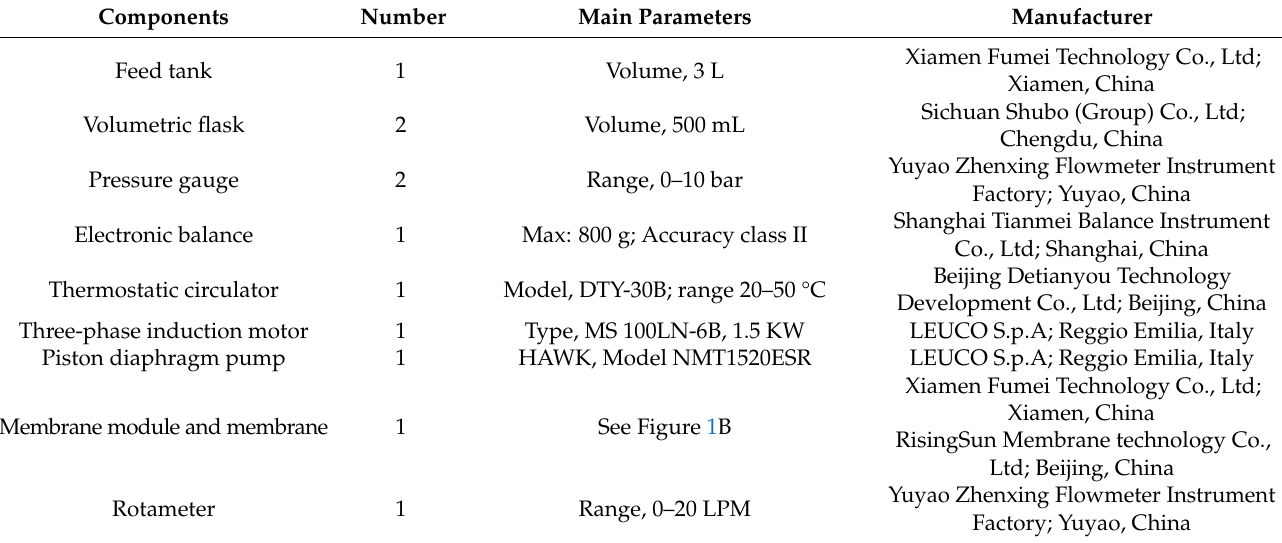
Table 2. Main components and related parameters of the membrane separation system.